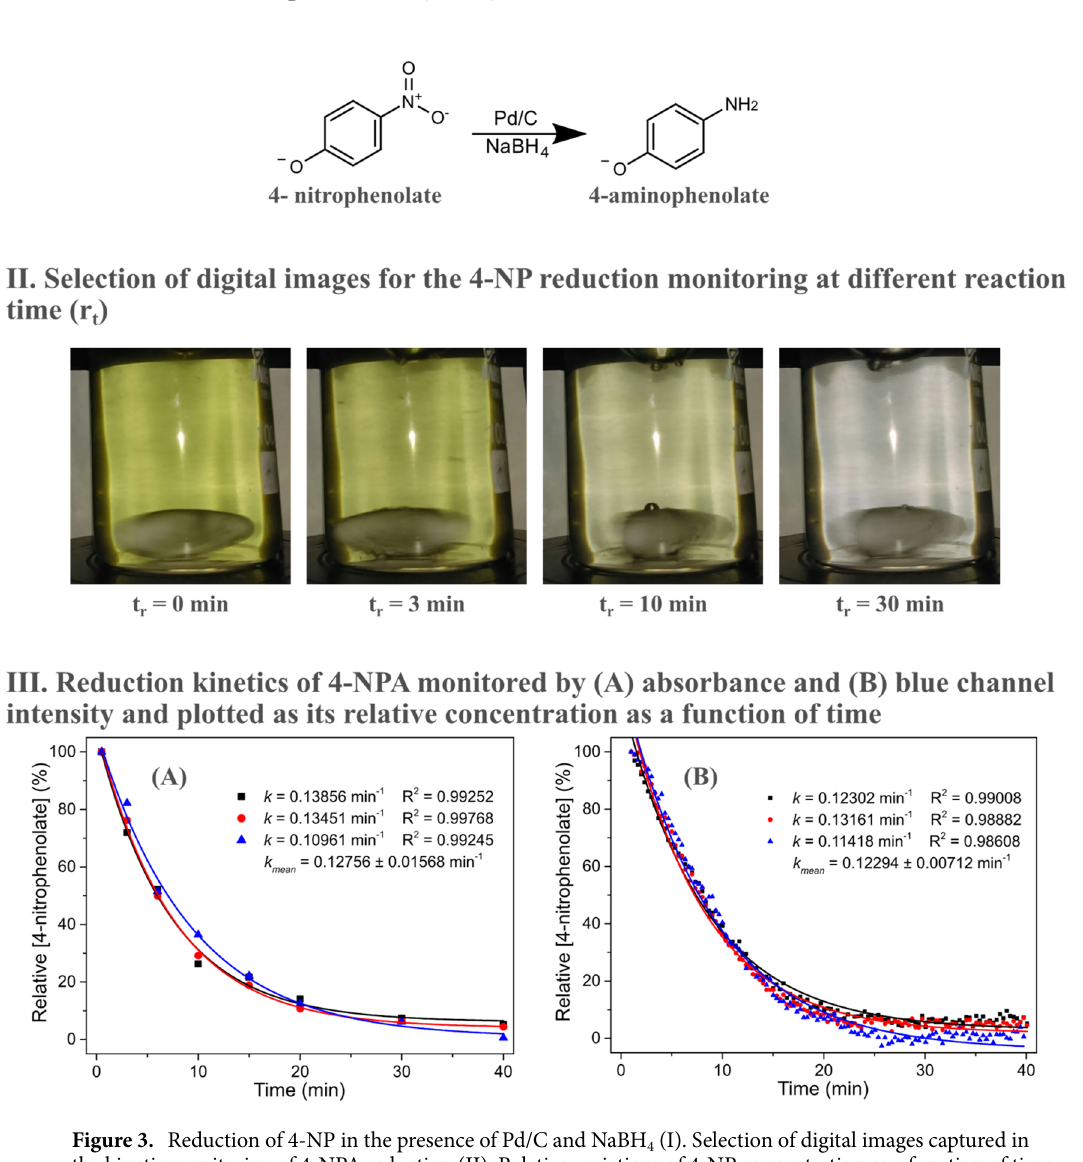
Figure 3. Reduction of 4-NP in the presence of Pd/C and NaBH 4 (I). Selection of digital images captured in the kinetic monitoring of 4-NPA reduction (II). Relative variations of 4-NP concentration as a function of